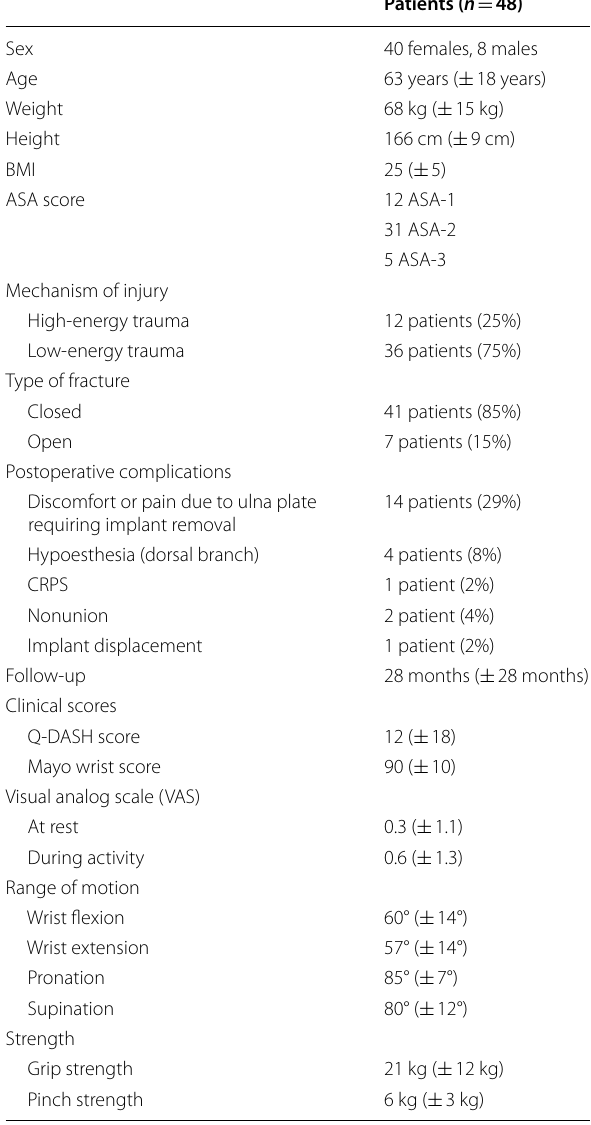
Table 1 Demographic data, postoperative complications, and clinical results at last